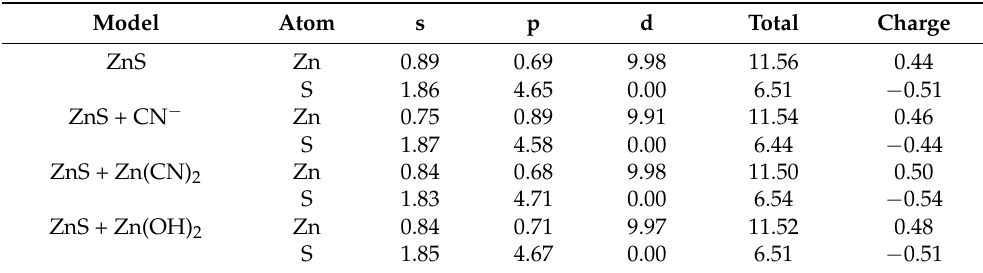
Table 2. Mulliken charge distribution before and after adsorption of CN − , Zn(CN) 2 , Zn(OH) 2 on the surface of sphalerite (110).